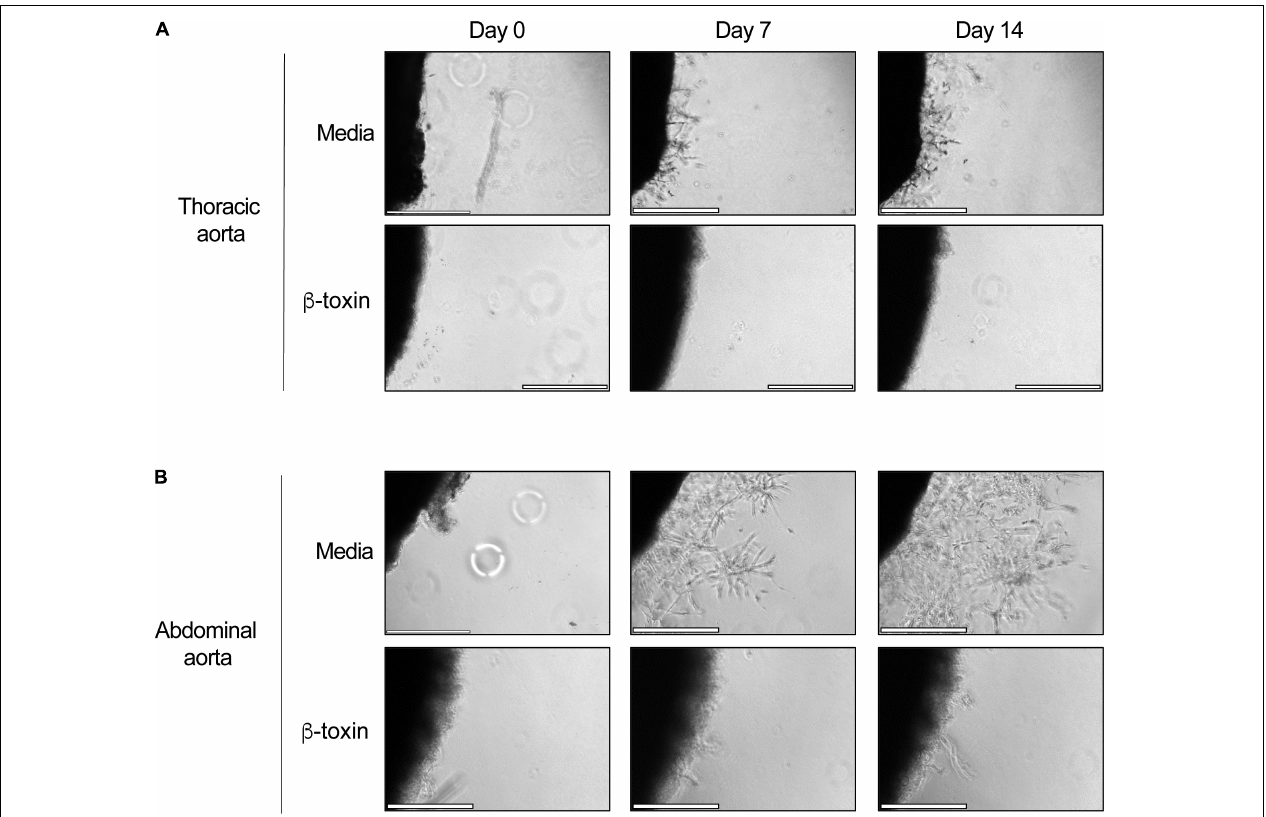
FIGURE 6 | β -toxin inhibits sprout formation. Thoracic and abdominal aortas were collected and sectioned from 2 to 3 kg New Zealand white rabbits. Rings were cultured on GFR-Matrigel in the presence or absence of β -toxin (50 µ g mL − 1 ). Scale bar = 500 µ m. (A) Phase-contrast microscopy of thoracic aortic rings. (B) Phase-contrast microscopy of abdominal aortic